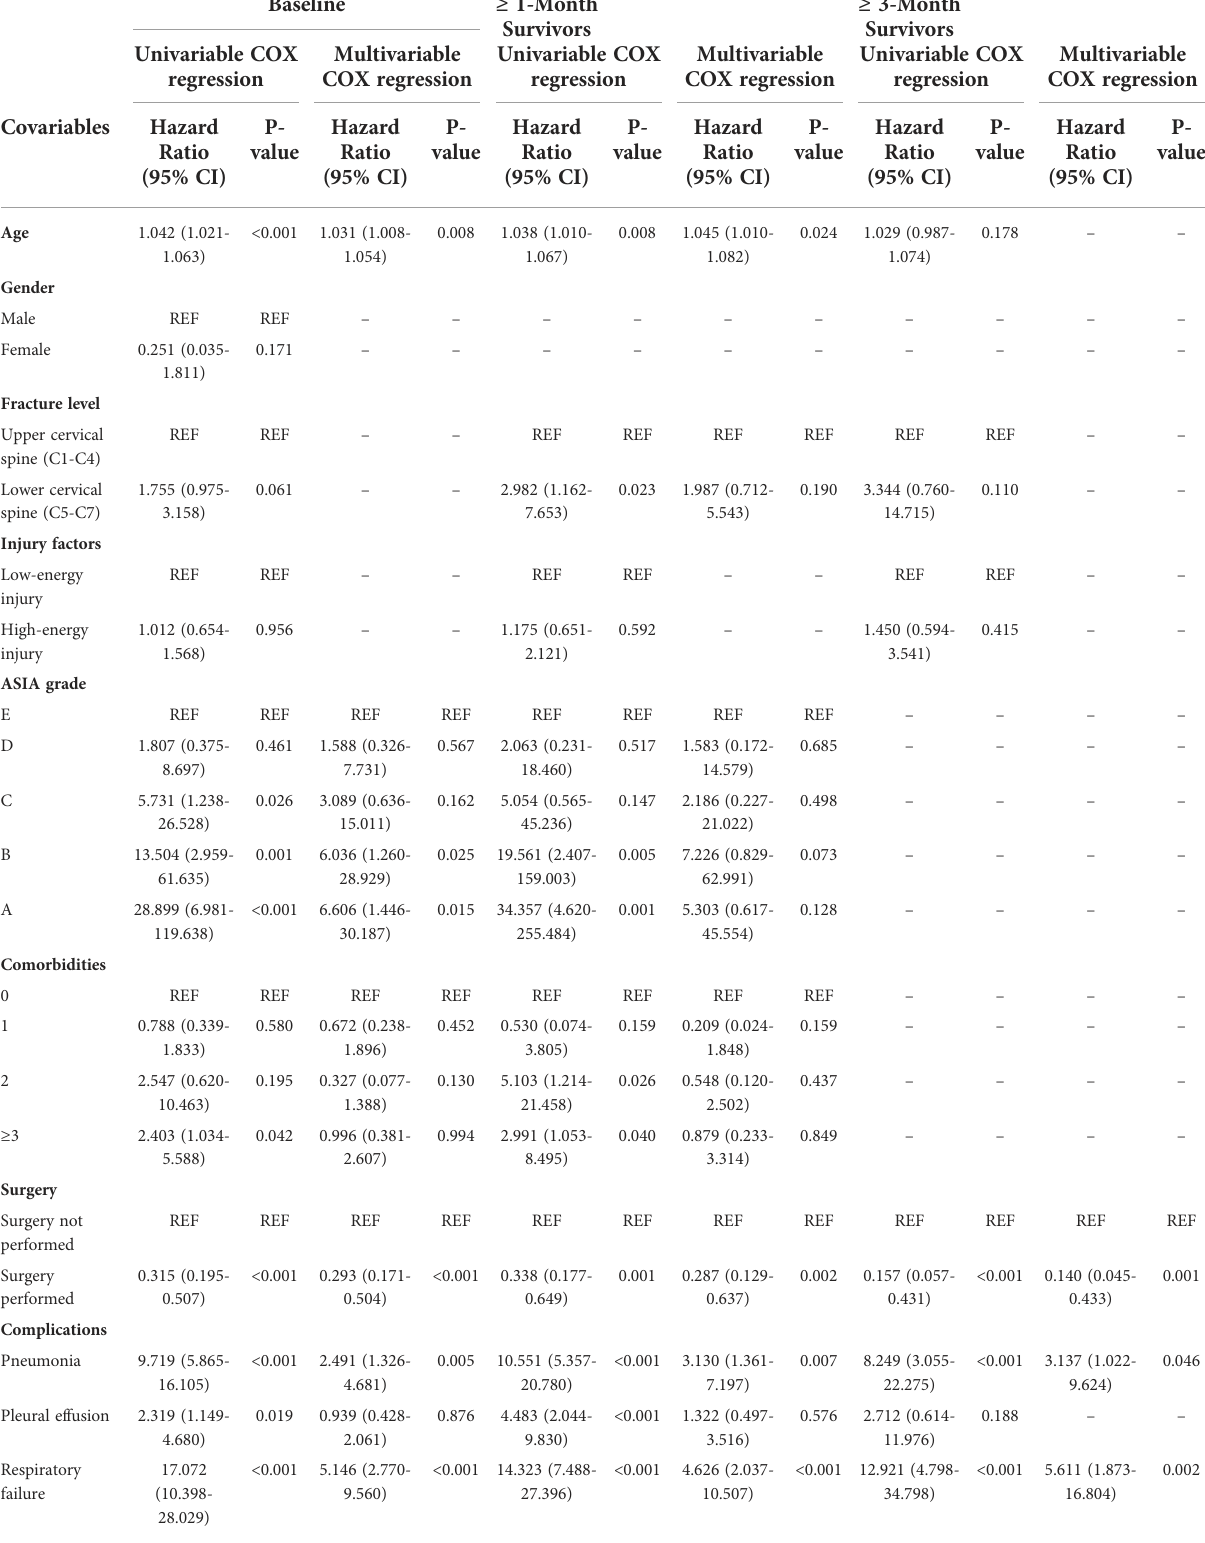
TABLE 2 COX regression results of the risk factors of mortality in baseline, ≥ 1- and 3-month